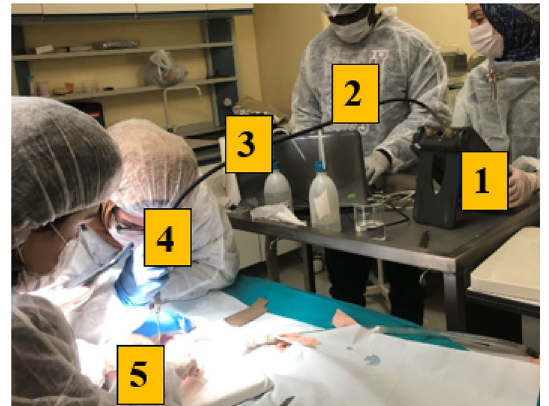
Figure 3. Measurement setup: ( 1 ) Agilent Fieldfox N9923A Network Analyzer (VNA), ( 2 ) Laptop computer connected to VNA via local area network (LAN) cable and Agilent IO program, ( 3 ) Keysight N1501A-202 20